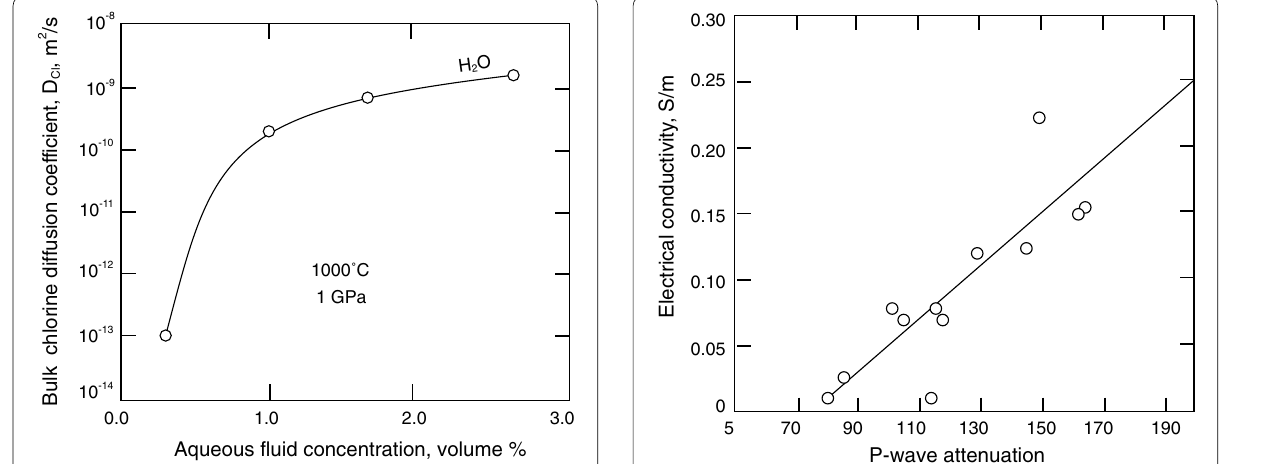
Fig. 41 Relationship between electrical conductivity and P -wave attenuation from a variety of fore-arc and back-arc subduction zones as discussed in Pommier (2014). Modified from Pommier (2014)